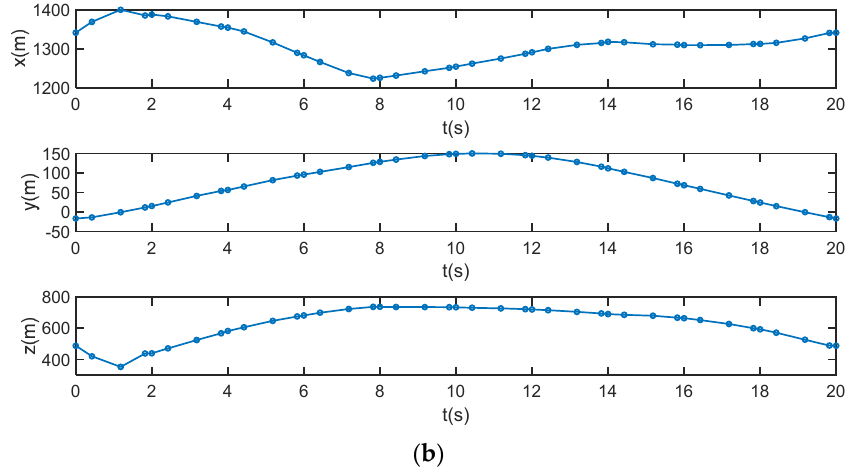
Figure 8. Optimal trajectory of the parafoil by PSM. ( a ) Three-dimensional trajectory; ( b ) Trajectory coordinates.